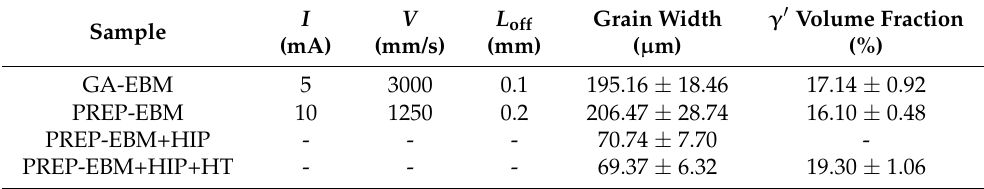
Table 5. Measured average grain width and γ′ volume fraction of as-EBM GAed and PREPed GH4099 samples and their changes due to HIP and HT. The building parameters of the GAed and PREPed sample are listed here.